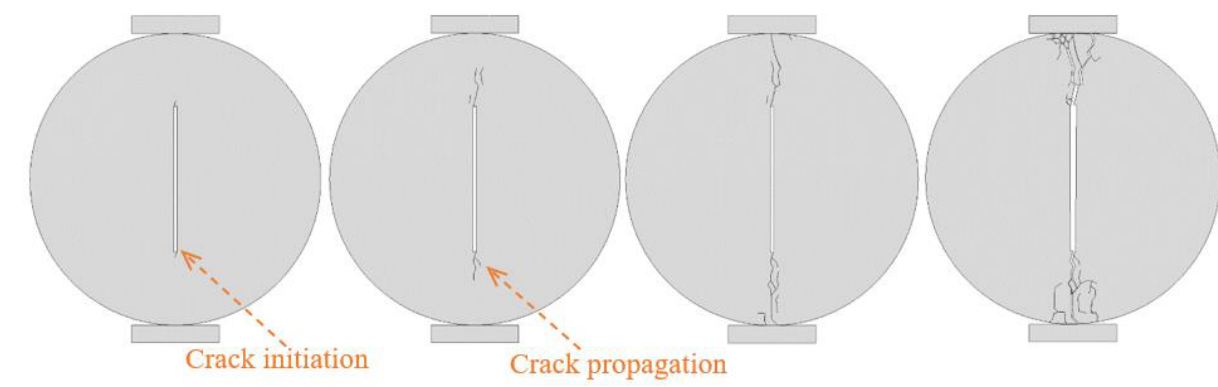
Figure 3. Fracture process for Brazilian disc with a crack of 0° angle.